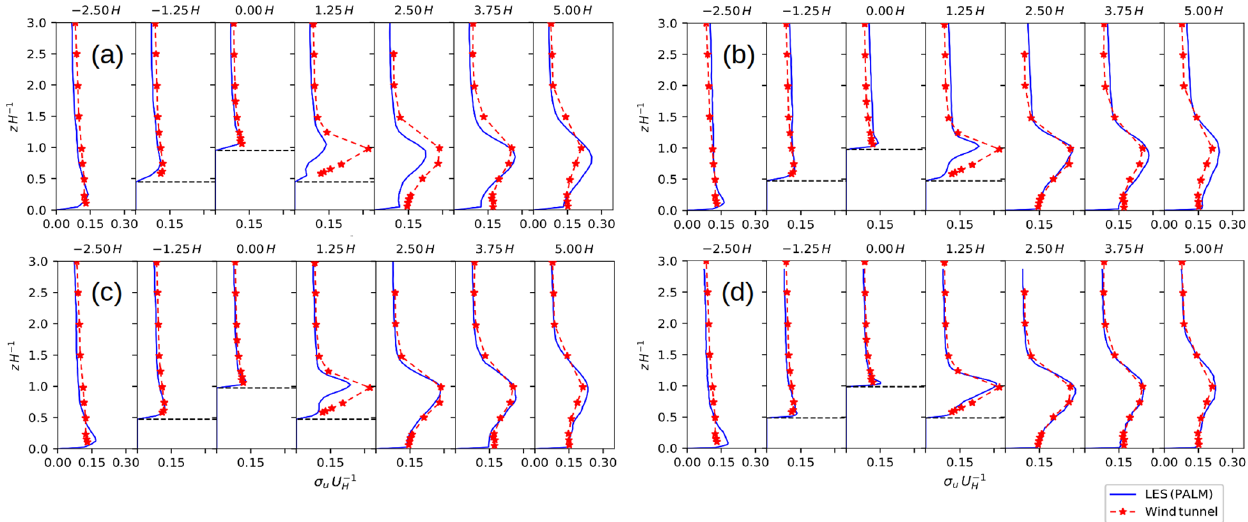
Figure 14. The 2h time-averaged vertical profiles of the standard deviation of the u component for the LES and the observed wind tunnel flow for (a) the 4m reference simulation, (b) the 2m reference simulation, (c) the 2m nested child simulation, and (d) the 1m nested child simulation. The ordinate is scaled with the hill height H . The standard deviation is normalized with the reference wind speed taken at z = H upwind of the hill. The horizontal dashed black lines indicate the discrete height of the surface at the sampling location. Note that the vertical dimension of the 1m nested child domain does not cover the entire vertical range of the measurements, and thus some data points from the LES are missing on the normalized height coordinate in (d) .